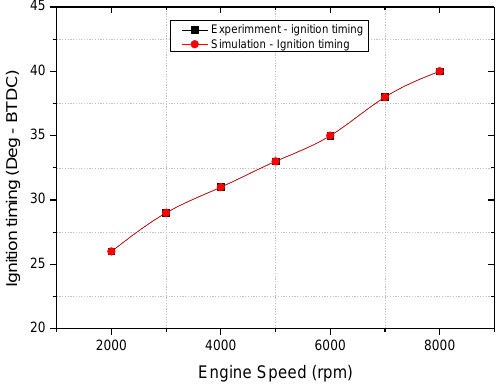
Figure 4. Ignition timing following engine speed.